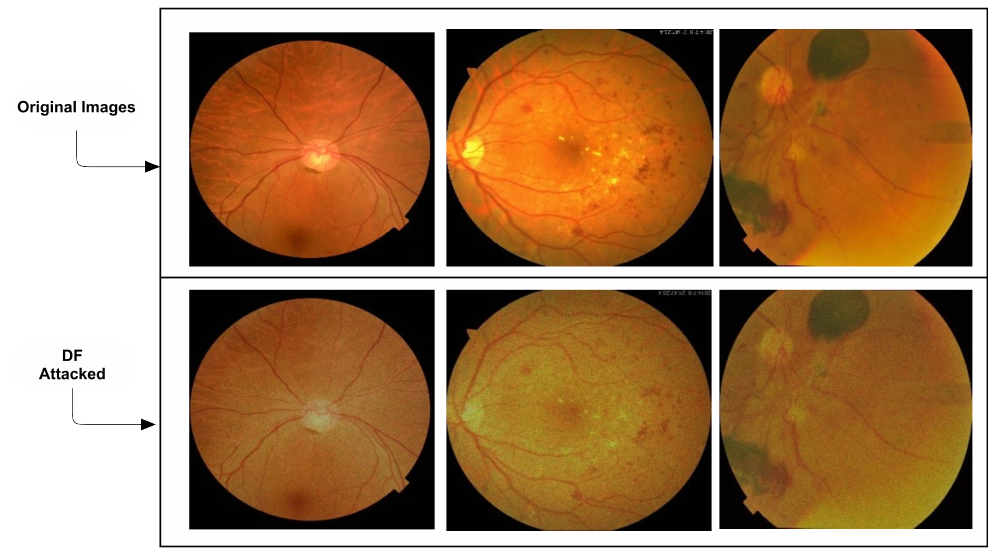
Figure 4. Addition of DF attacks. The first row shows the original images, while the second row indicates the DF attacked